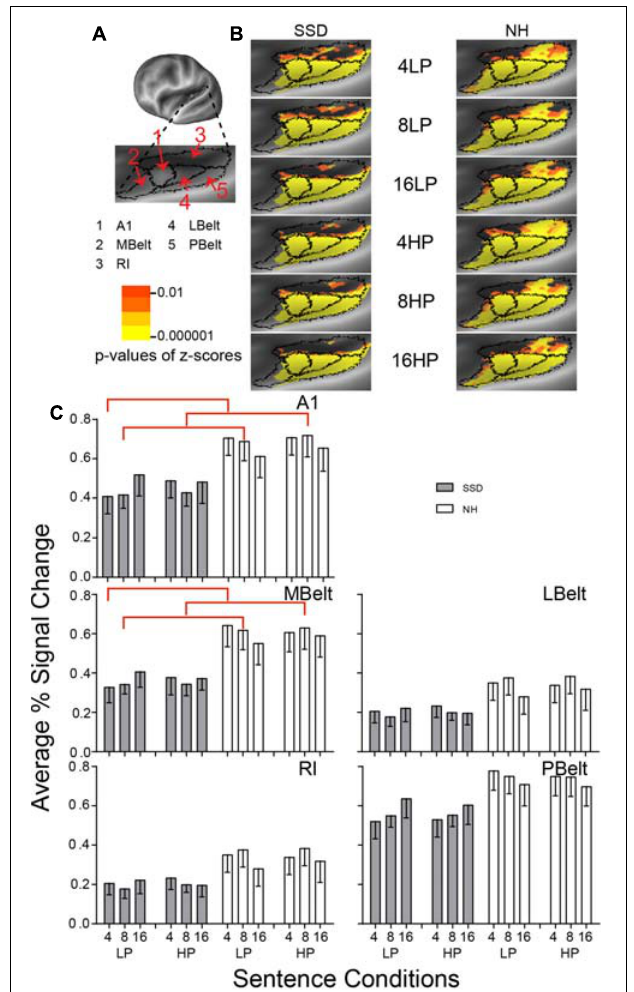
FIGURE 3 | Results from five parcels in the left hemisphere (LH) Early Auditory Cortex (EAC) region. (A) A lateral view of an inflated LH reveals the location of EAC and its five parcels along the superior temporal plane. A lateral and inferior rotation revealed the superior temporal plane. (B) Enlarged views of parcels show clusters with significant mean z-scores of p < 0.01 for positive BOLD (colored red-orange to bright yellow), for each sentence condition (rows) in the SSD and NH groups (left and right columns). Results in the top and bottom three rows were, respectively, for LP and HP sentences. Results displayed in successive three rows per predictability level were for increasingly intelligible sentences with 4-, 8-, and 16-band noise-vocoding. (C) Bar graphs show mean and SEM of percent signal change averaged across all vertices per named parcel in LH cortex. A1 and MBelt had significant group differences marked with red brackets. Vertical arrangement of sentence conditions within each panel follows the same sequence shown in B. NH, normal hearing (white bars); SSD, single sided right ear deafness (gray